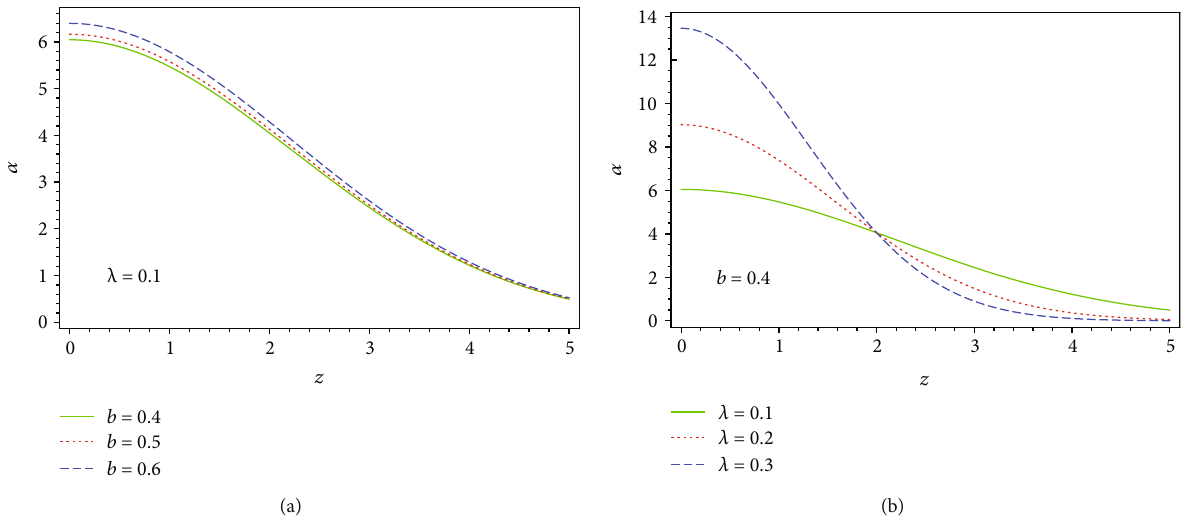
Figure 5: Considering α versus z coordinate at (a) di ff erent temperatures and (b) di ff erent scale parameters.